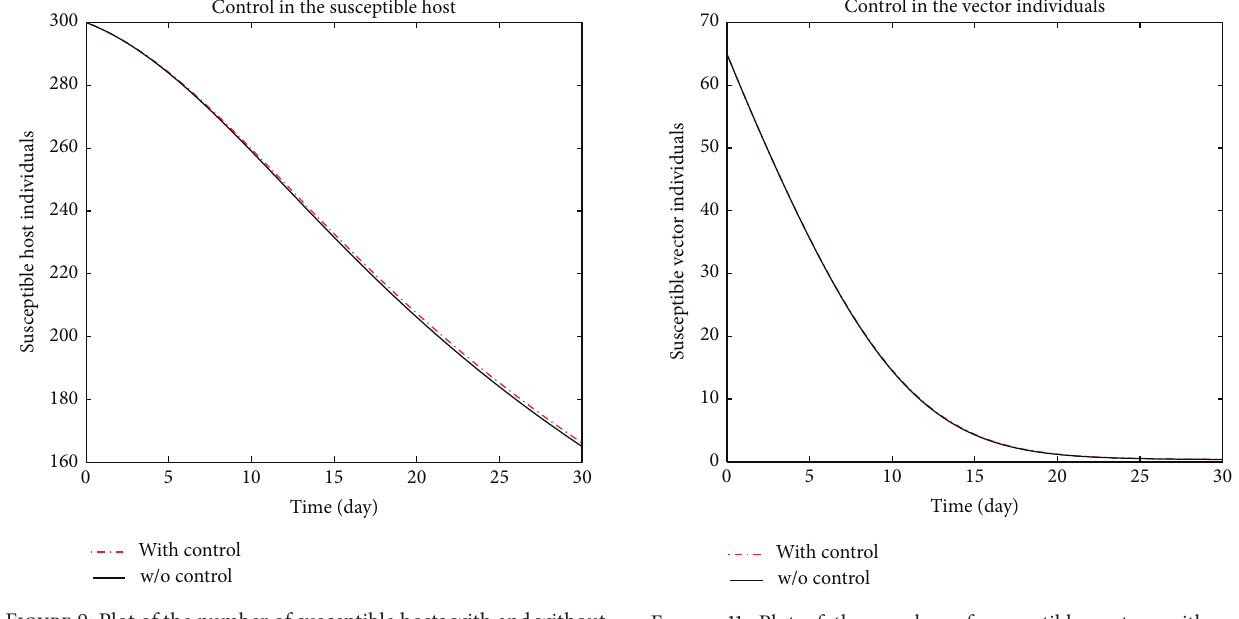
Figure 11: Plot of the number of susceptible vectors with and without control, 𝑢 1 ̸= 0 , 𝑢 2 = 0 .